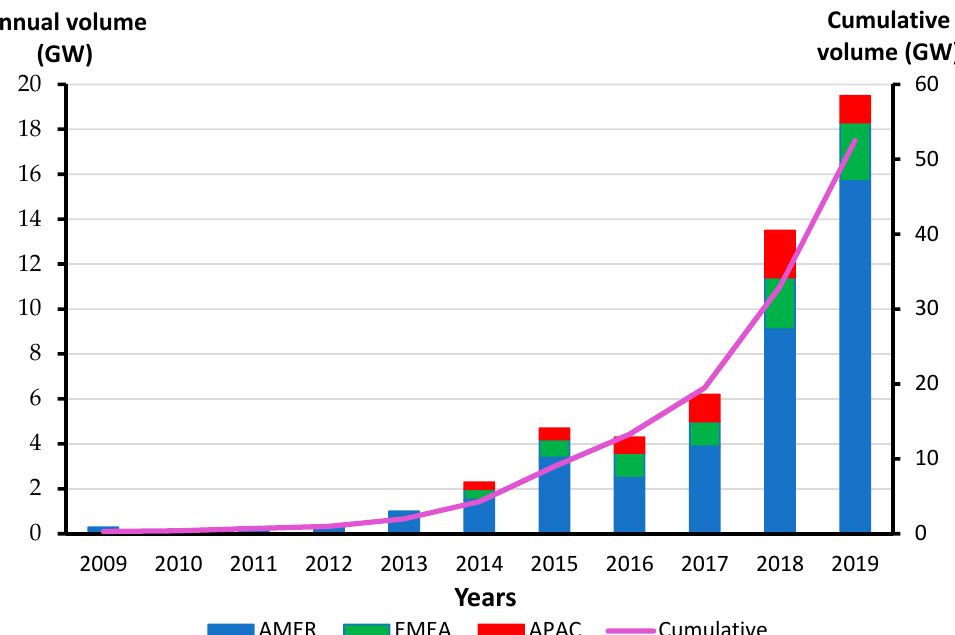
Figure 8. Total volume of corporate power purchase agreements (PPAs) (where AMER = Americas Region, EMEA = Europe, Middle East, and Africa, APAC = Asia Pacific) [35].